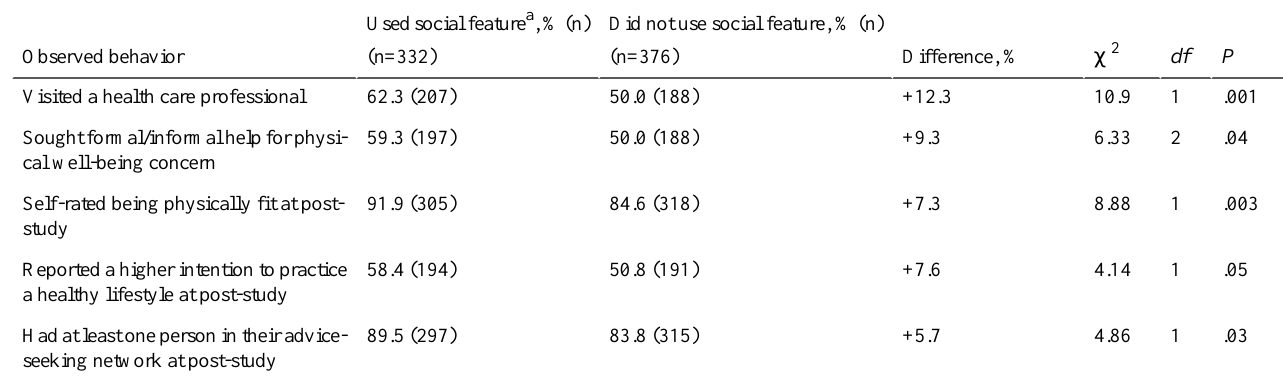
Table 1. Users of PCHMS social features (forum or poll) versus nonusers.